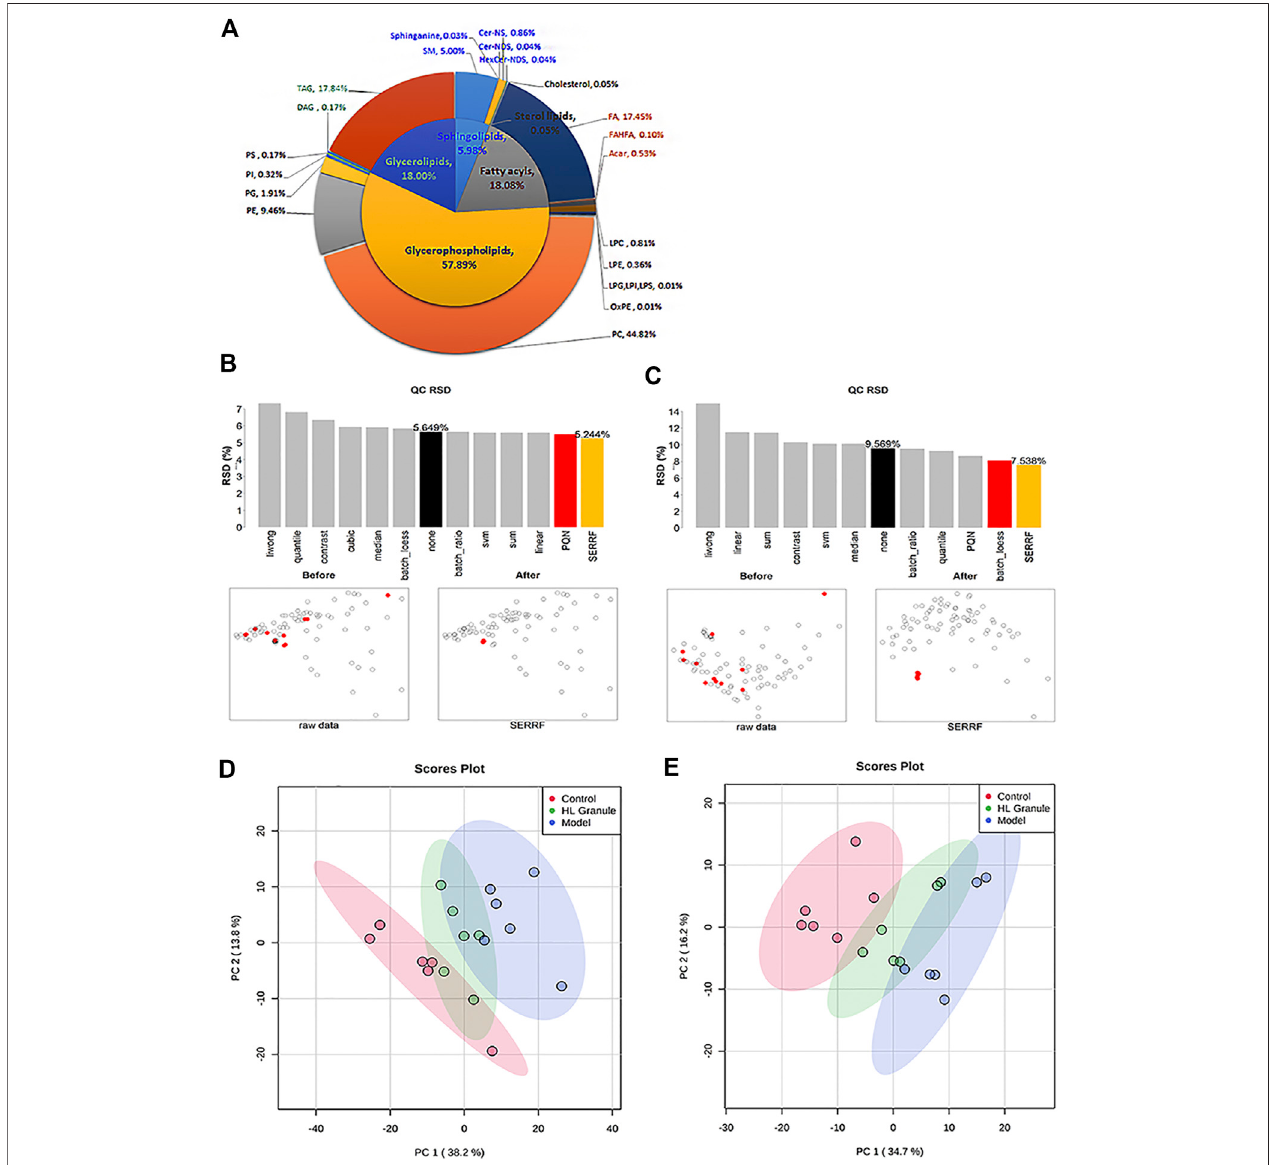
FIGURE 3 | lipids related to HL Granule treatment of acute asthma. (A) Double pie chart of lipids detected in lung tissue of acute asthma mice in positive and negativeion mode. (B, C) RSD and scatter plots oflipids in samples and QCsafter normalization in positive (B) and negative ion mode (C) . (D, E) PCA of lipids in lung of mice in positive (D) and negative ion mode (E) , n (cid:2)